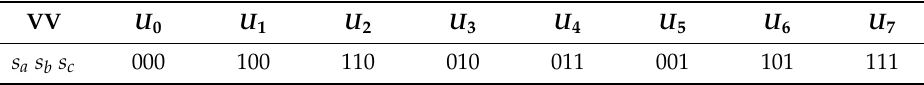
Table 1. Voltage vectors (VVs) of voltage source inverter (VSI).